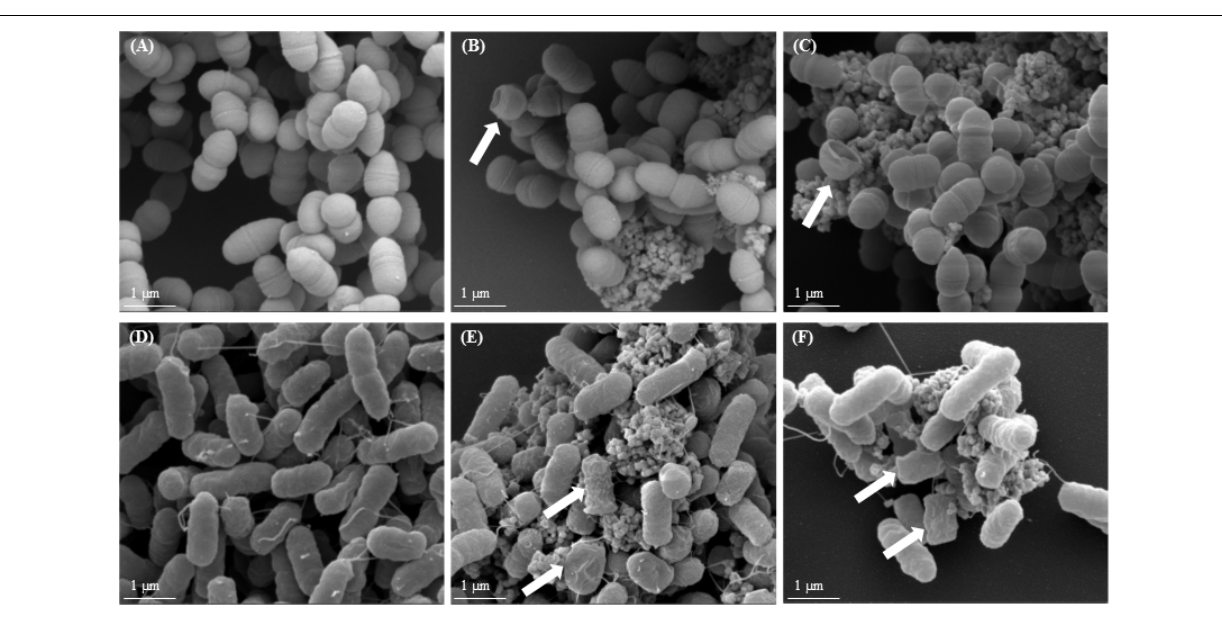
FIGURE 4 | Scanning electron microscopy (SEM) images of bacterial cells after TiO 2 exposure. (A,D) non-exposed growing bacterial cells, (B,E) growing bacterial cells exposed to E171-A 320 µ g/mL, and (C,F) growing bacterial cells exposed to E171-D 320 µ g/mL; (A–C) L. lactis IBB477, (D–F) E. coli K12 MG1655. White arrows indicate damaged bacterial